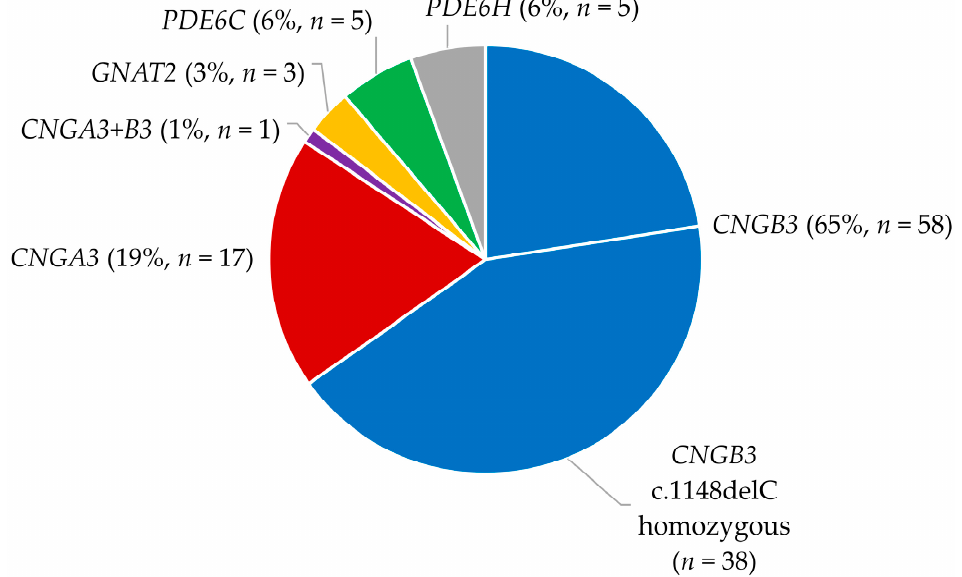
Figure 1. Distribution of genes with disease-causing variants in Danish ACHM patients.